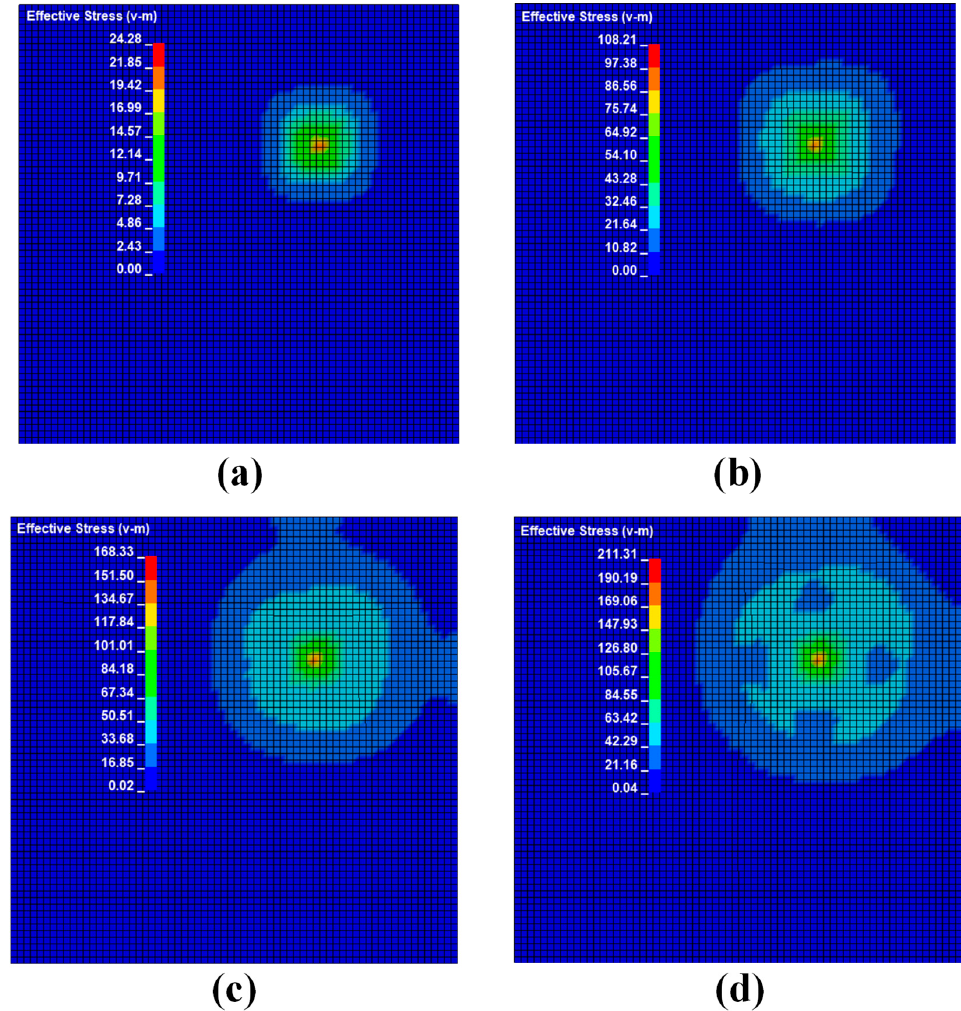
Figure 12. Stress cloud diagram of impact response at different velocities at position 3: ( a ) shock response stress cloud diagram at an impact speed of 1 m/s; ( b ) shock response stress cloud diagram at an impact speed of 1.5 m/s; ( c ) shock response stress cloud diagram at an impact speed of 2 m/s; ( d ) shock response stress cloud diagram at an impact speed of 2.5 m/s.